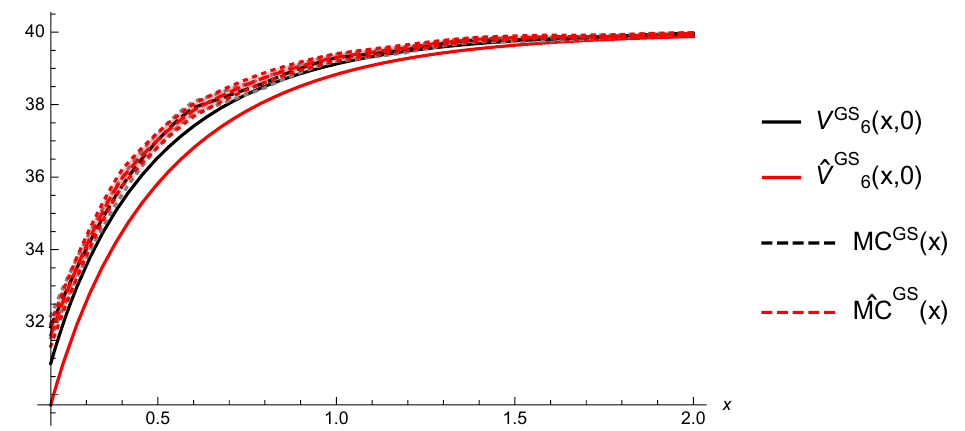
Figure 8. Comparison of solution with and without estimation together with their MC simulated